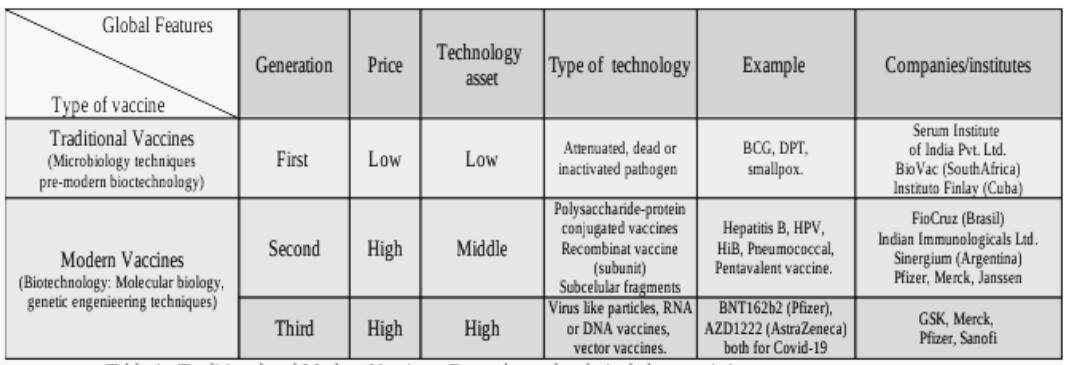
Table 1: Traditional and Modern Vaccines: Examples and Technical Characteristics